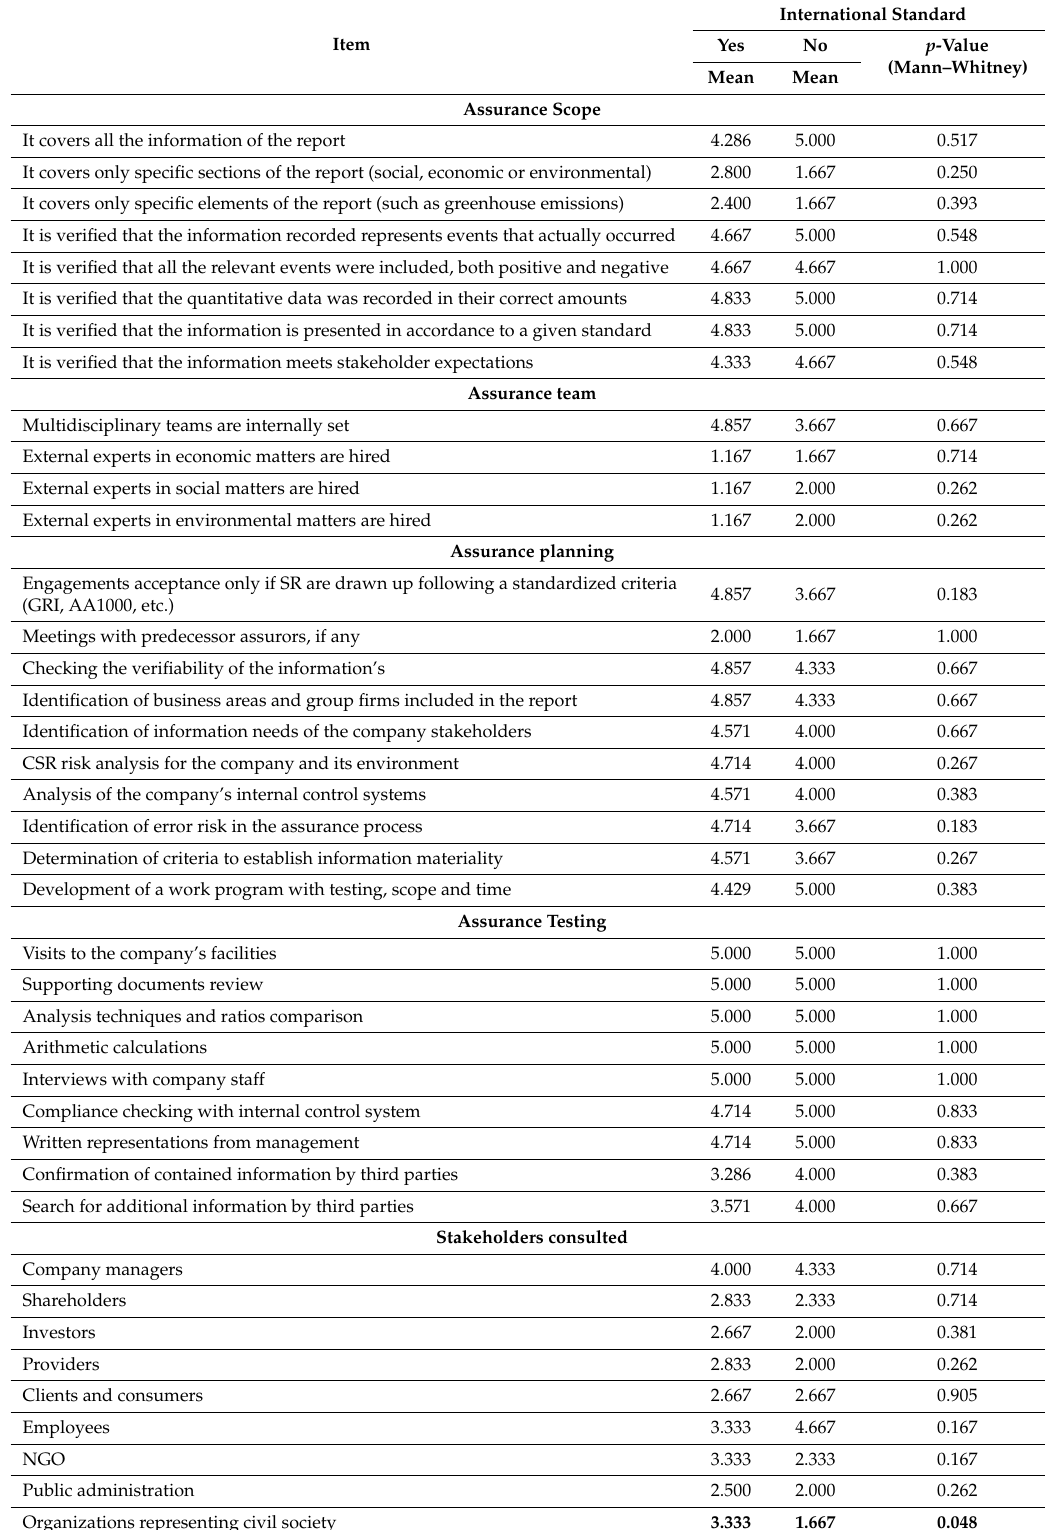
Table 9. Assurance process vs. international